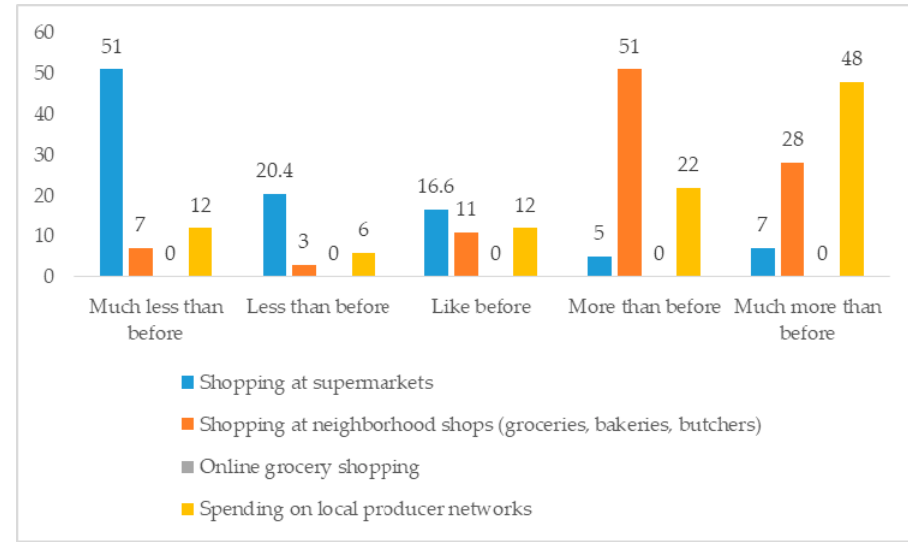
Figure 3. Changes in food shopping (%). Source: own processing of pilot survey.